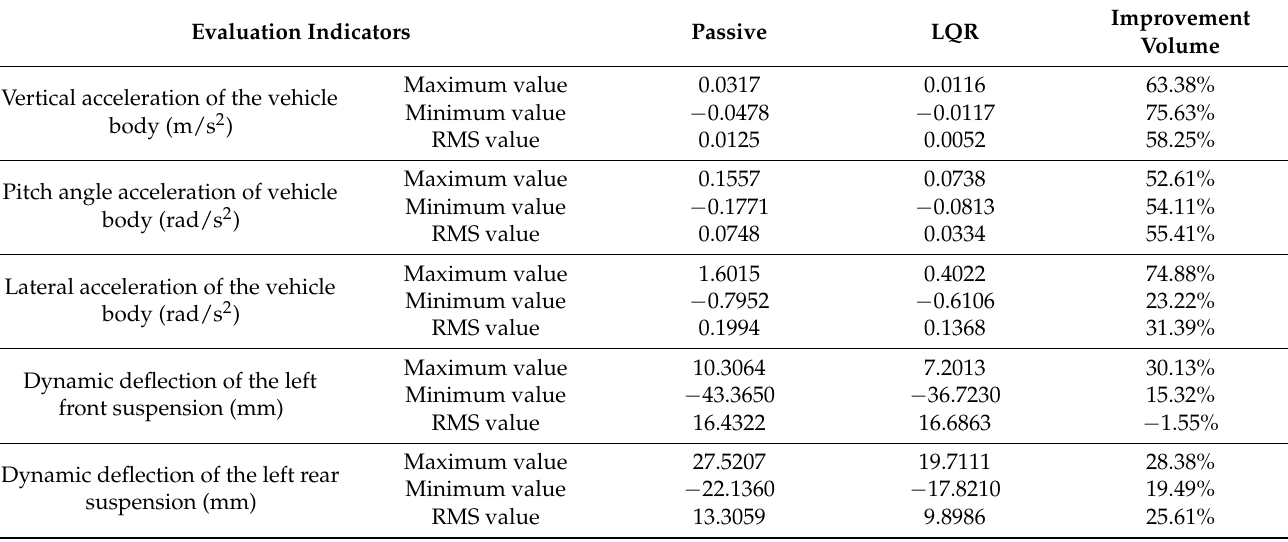
Table 9. Comparison of the maximum, minimum, and RMS values for the simulation of the double shift line condition with low adhesion